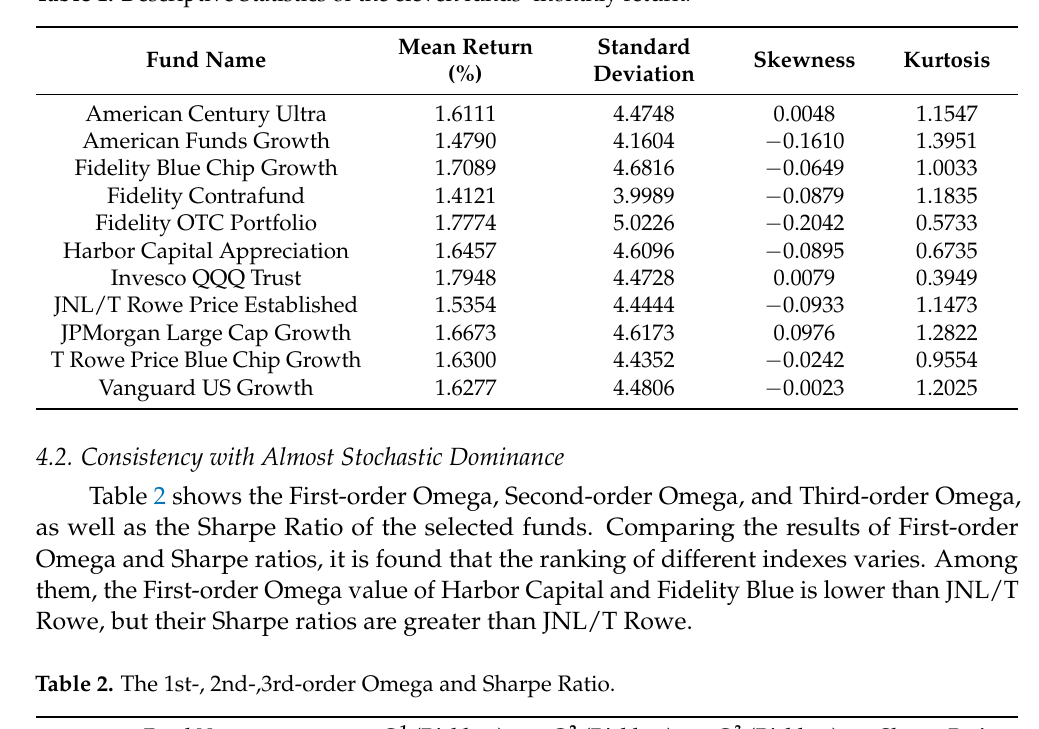
Table 1. Descriptive Statistics of the eleven funds’ monthly return.